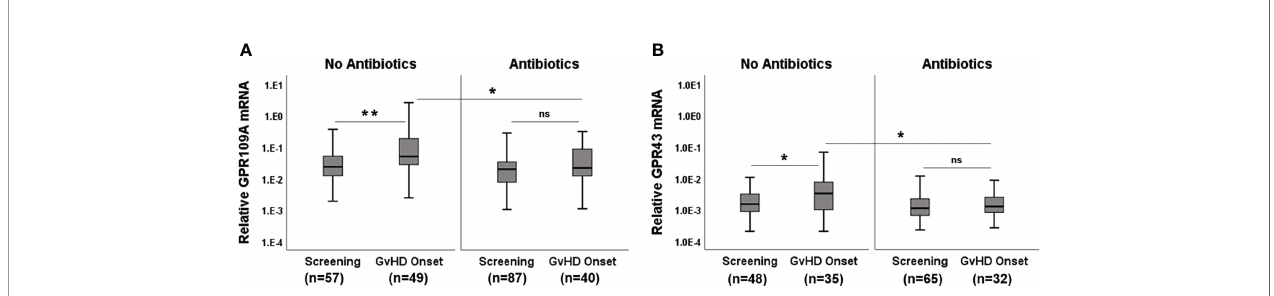
FIGURE 3 | Effect of Abx at the onset of GvHD. (A) GPR109A expression at GvHD onset without or with Abx. (B) GPR43 expression at GvHD onset without or with Abx. *p < 0.05, **p < 0.01, Mann-Whitney U test. ns, not signi fi